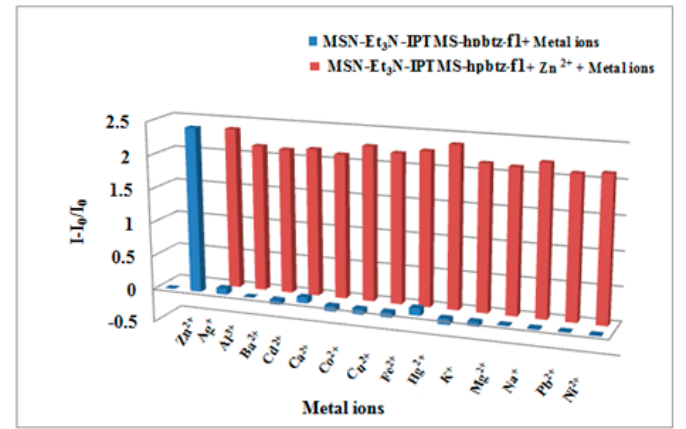
Figure 15. Variation of the fluorescence intensity of MSN-Et 3 N-IPTMS-hpbtz- f1 (2 mg mL − 1 ), with Zn 2+ (15.4 equivalent, 350 µL) and various metal ions (two times more in equivalent) at 460 nm ( λ ex = 305 nm) in ethanol.